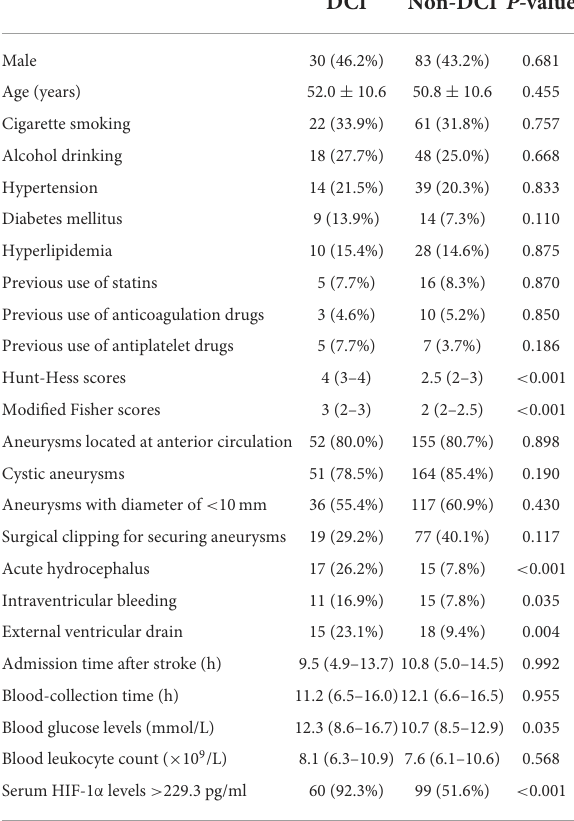
TABLE 3 Factors in relation to delayed cerebral ischemia following aneurysmal subarachnoid